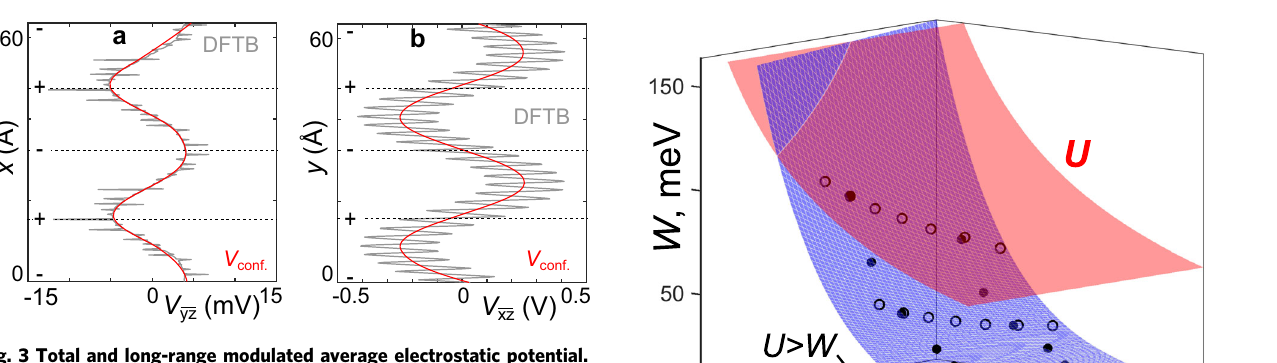
Fig. 3 Total and long-range modulated average electrostatic potential. Electrostatic potential along ( a ) x , and ( b ) y and averaged along the other two perpendicular directions. The solid gray lines correspond to the calculated averaged potential, while the thin red lines correspond to the long-range potential modulation extracted by Gaussian averaging. The + and − mark tensile and compressive regions.